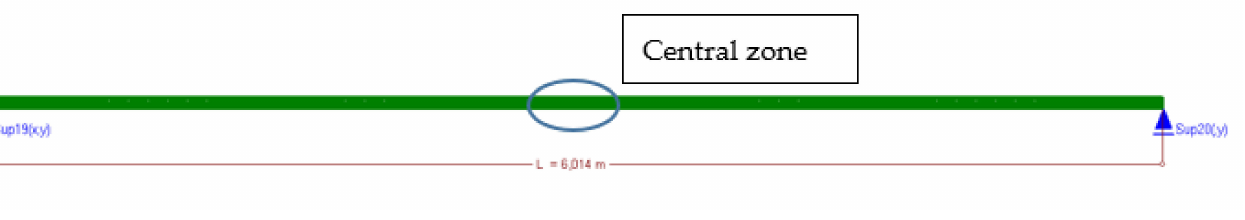
Figure 27. Computer model of the research structure.